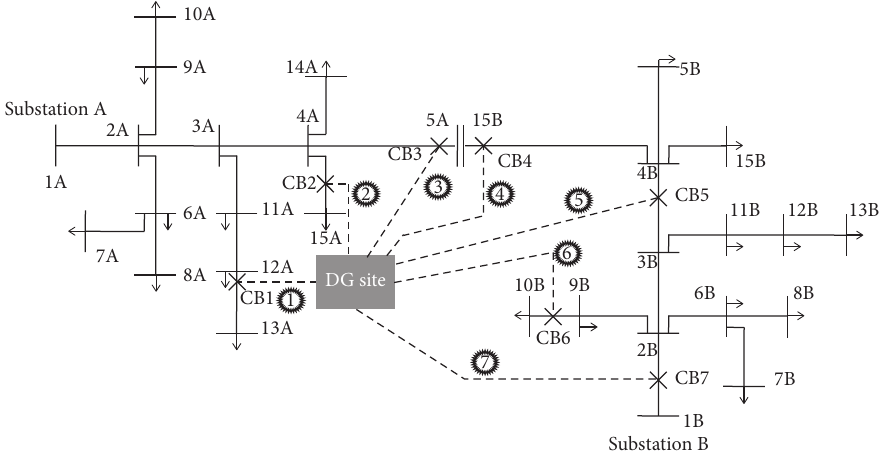
Figure 1: Single line diagram of the case study (topology structure no.